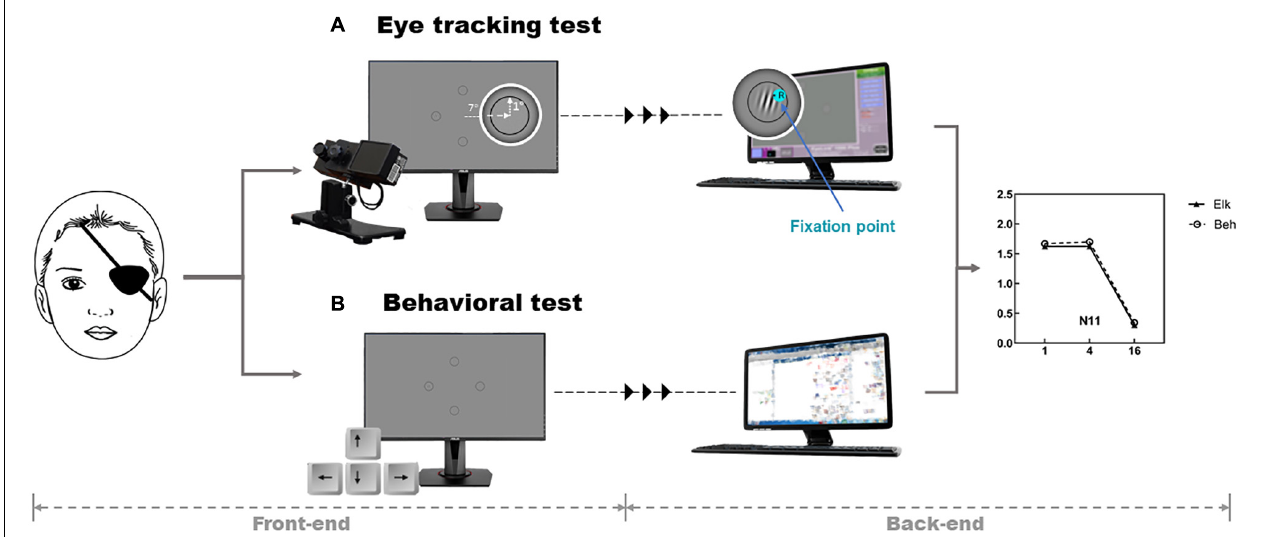
FIGURE 1 | Graphical representation of the study task and procedure. The front-end is the interface on which the subjects performed the test. Monocular CS was estimated via an (A) eye tracking test and a conventional psychophysical method [ (B) Behavioral test], which were both based on a five-alternative forced-choice grating detection task. The task stimuli were the gratings that randomly appeared in one of the four circles, which are equidistant from the tested eye. Each circle had a radius of 1 ◦ and were located at the upper, lower, left and right sides, 7 ◦ away from the center point of the screen. The observer was instructed to stare at the location where the stimulus appeared and the fixation points recorded by the eye tracker were transmitted to a second monitor. The same task was performed in the Behavioral test using the four arrow keys on a computer keyboard to report perceived location of the stimuli. The examiners observed the subjects’ fixation points and key presses on the second monitor (the back-end) and an automated algorithm presented the next stimulus and determined the contrast threshold. Then, the contrast threshold obtained with two methods were compared across spatial frequencies. elk, eye tracking test; beh, behavioral test (conventional perceptual report).